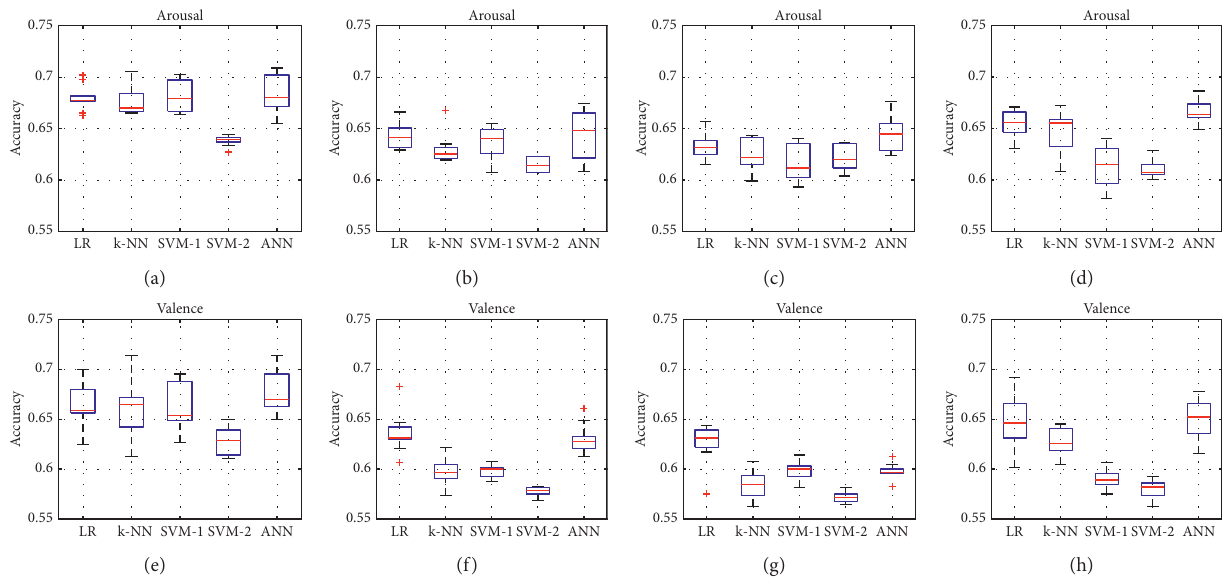
Figure 6: The recognition accuracy for four types of EEG features in two emotion dimensions under different classifiers. (a) Global MIC features in the arousal dimension. (b) Fusion features in the arousal dimension. (c) Frequency-domain features in the arousal dimension. (d) Time-domain features in the arousal dimension. (e) Global MIC features in the valence dimension. (f) Fusion features in the valence dimension. (g) Frequency-domain features in the valence dimension. (h) Time-domain features in the valence dimension.